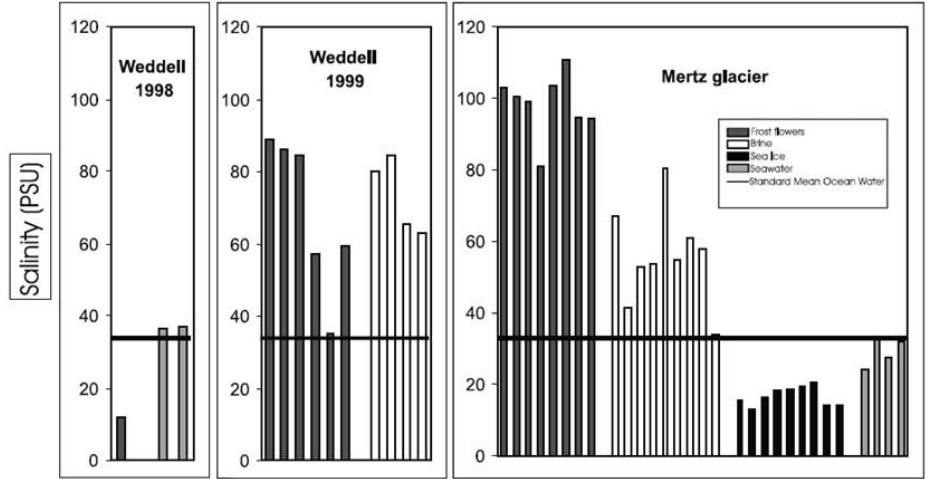
Fig. 2. Salinities of frost flowers (darker grey), slush (white), ice (black) and seawater (lighter grey). Taken from Rankin et al. (2002) with permission of the American Geophysical